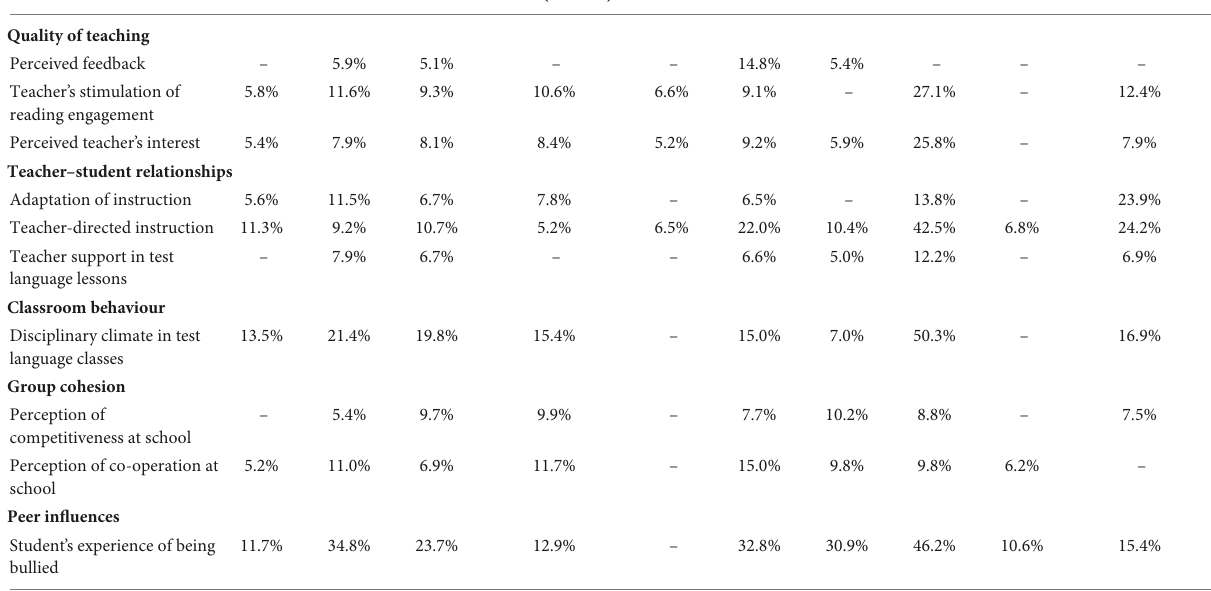
TABLE 8 Standardised importance of the independent teacher and school